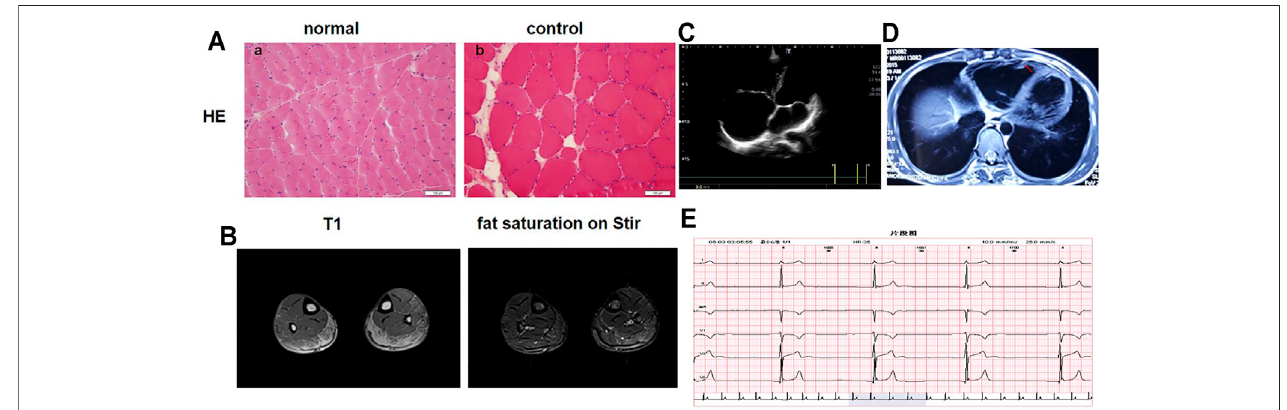
FIGURE 1 | Clinical Results. (A) Muscle biopsy. (a) Hematoxylin and eosin (H&E) staining of serial sections of the skeletal muscle from a normal control. (b) H&E staining of the skeletal muscle of the proband shows dystrophic changes: variability in the size of muscle fi bers, fi brosis, and fat replacement. (B) Limb muscle MRI showed in fi ltration of fatty tissues in the soleus. (C) Echocardiography showed enlargement of the right heart. (D) Cardiac magnetic resonance imaging revealed an obviously enlarged right heart and evident thinning of the lateral wall of the right ventricle. The red arrows show fatty tissues in the local cardiac muscle. (E) Holter monitoring showed bradycardia and a junctional ectopic